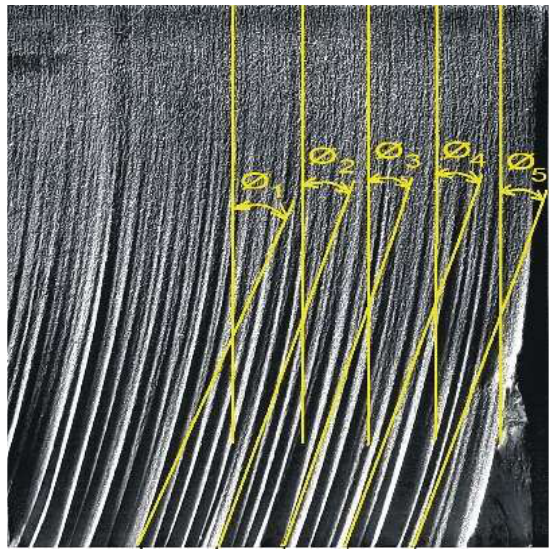
Figure 4. Localization of the measurement of the deflection of the abrasive water jet trace on the cut surface.